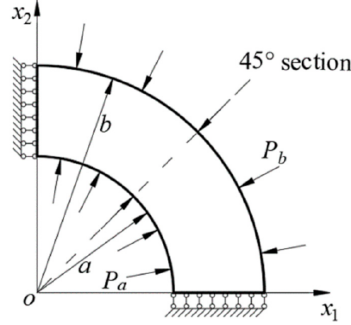
Figure 8. A quarter of the